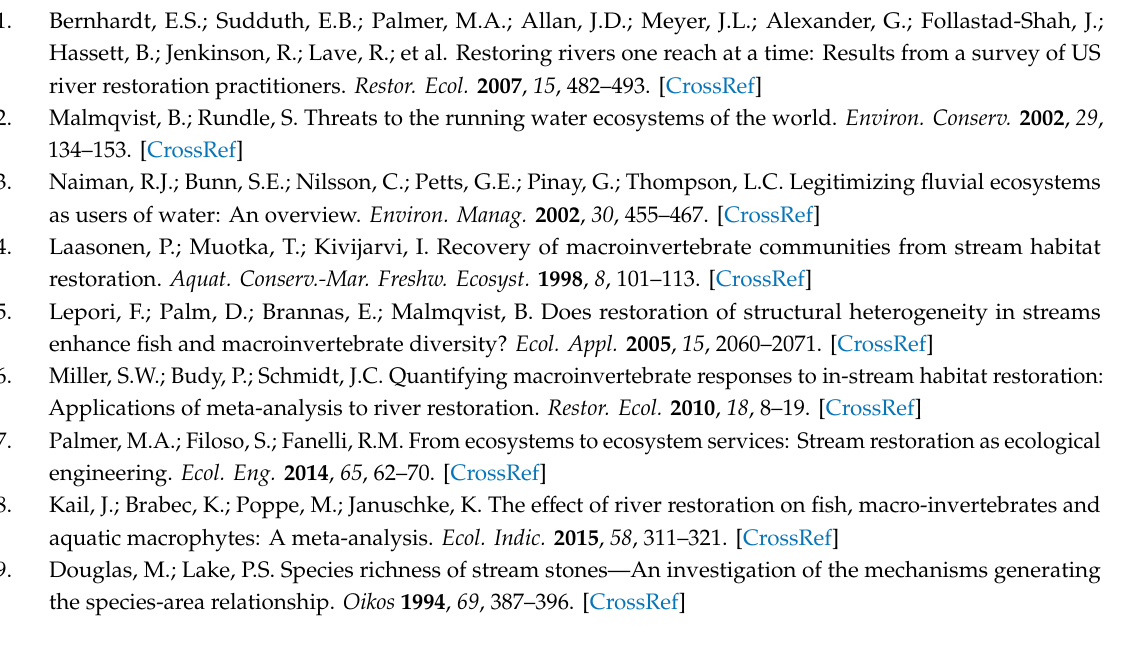
Table S1: Detailed location data and habitat information for the nine study sites within the Anji City Region, PRC; Habitat information include canopy cover, habitat types, substrate composition and substrate Shannon index (H’). F = forest streams; R = restored streams; D = degraded